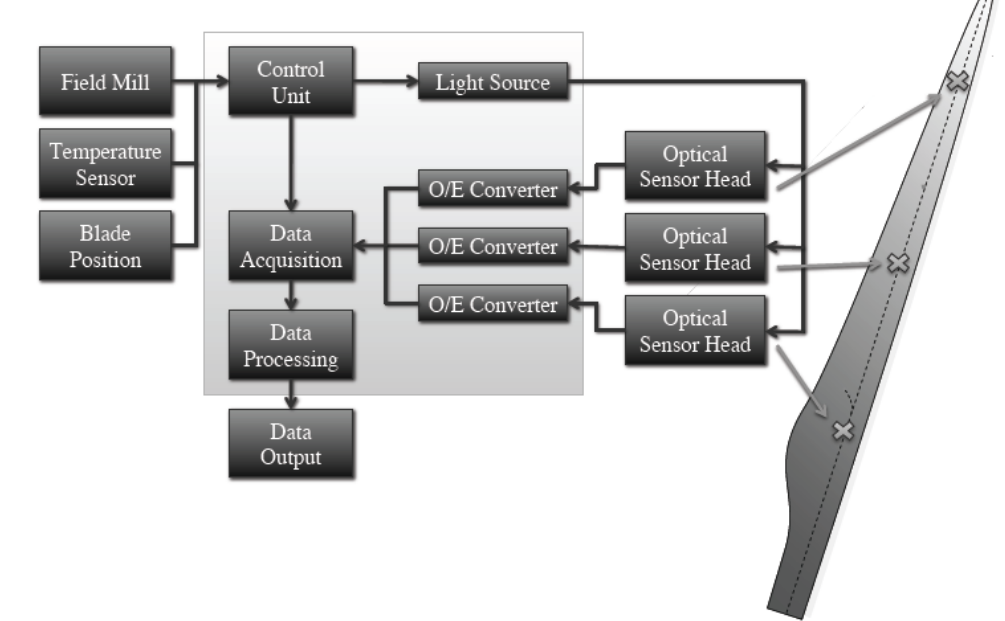
Figure 1. Fiber optic sensor network for monitoring lightning impacts on wind turbine blades